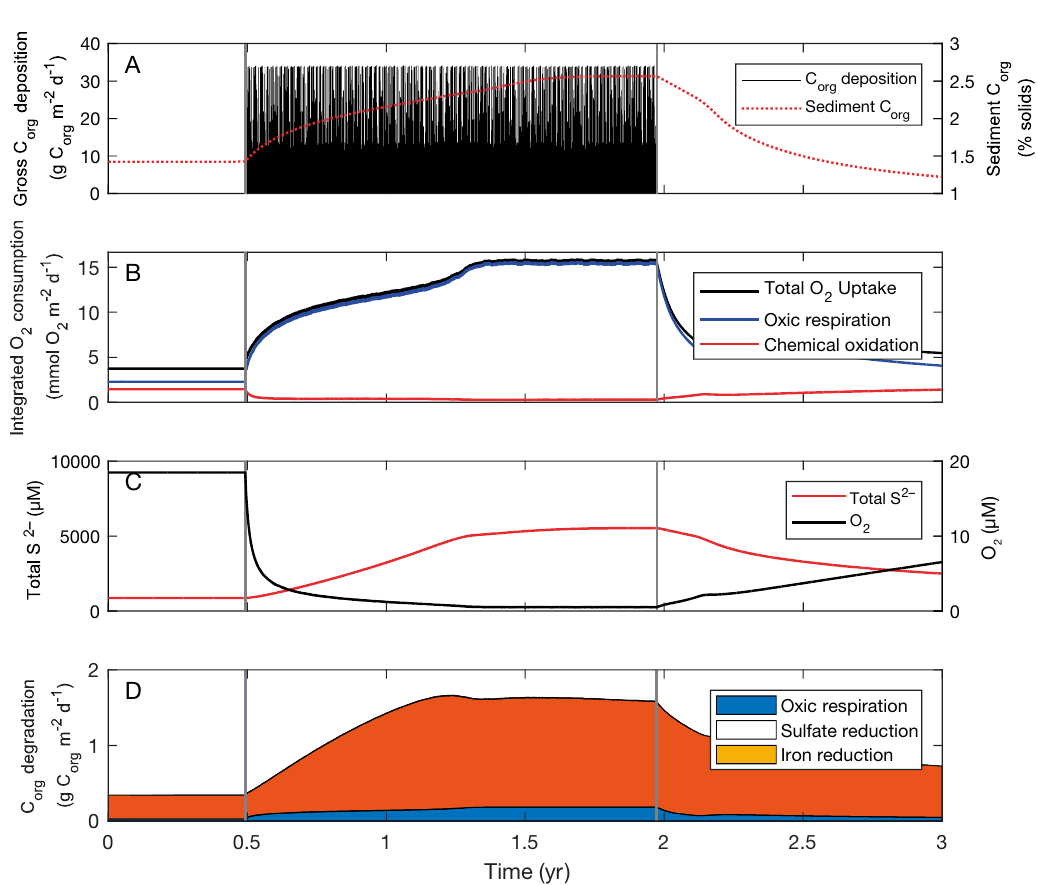
Fig. 2. Forcing and state variables in a temporal simulation of organic waste processing in sediments underlying a fish farm cage according to parameters of Table 1 and assuming a feed wastage of 3%. Vertical gray lines at 0.5 and 1.97 yr delineate the farming cycle. This simulation corresponds to the high deposition case (H-DEPO) defined in Table 3. Parameters of the simulation are as follows: length of fish farm production cycle, 18 mo; mean free-stream bottom current speed, 3.1 ± 2.2 cm s −1 ; daily accumulated wastage rate (feces plus lost feed), 19.4 g C org m −2 d −1 , C org : organic carbon; average daily organic waste deposition (gross value), 2.3 g